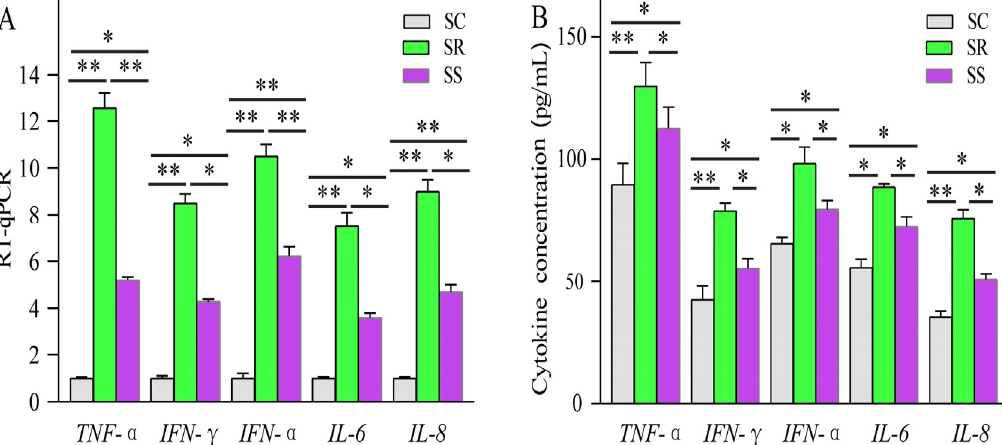
Figure 10. Cytokine gene expression levels ( A ) and concentrations ( B ) in the spleen. Data are displayed as Mean ± SE with three duplicates. One-way ANOVA was performed to calculate statistical significance followed by Duncan’s test. Different asterisks above bars indicate significant differences (* p < 0.05, ** p < 0.01).